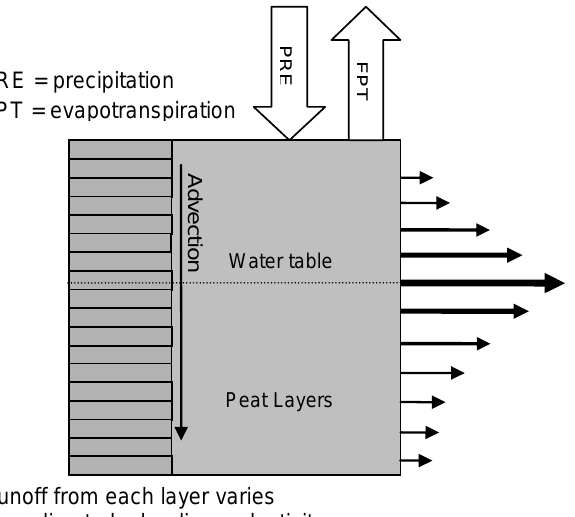
Fig. 3. Plant competition for nutrient and light.